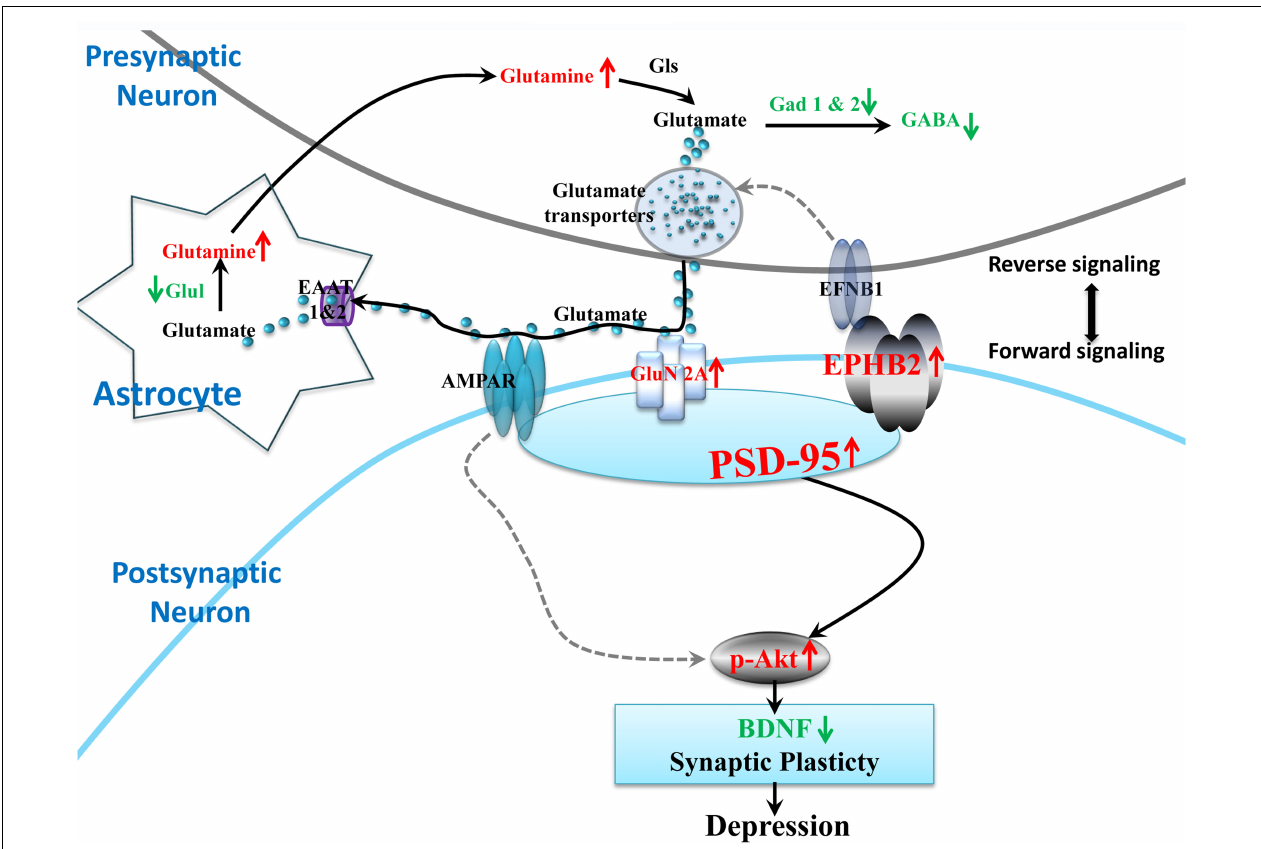
FIGURE 8 | Proposed model of the EPHB2 signaling cascade that regulates the synaptic plasticity through the phosphorylation of AKT under neuroinflammation-associated perturbation of glutamatergic transmission. LPS intervention influences the glutamatergic system, including decreased important enzymes of the glutamate metabolic pathway (Glul, Gad1, Gad2), and the elevated pivotal GluN2A receptor of glutamatergic synapse. Additionally, LPS elevates the expression of EPHB2, PSD-95 and phosphorylation of AKT (p-AKT) in the hypothalamus. EPHB2 may regulate neuroinflammation stress vulnerability by modulating synaptic plasticity via possibly facilitating GluN2A traffic, and then activating their specifically interacted protein, PSD-95. Next, the phosphorylation of AKT leads to the impairment of synaptic plasticity and ultimately depressive-like behavior. Molecular symbols with the up red arrow indicate upregulation, while those with the green arrow indicate downregulation in the LPS group compared with that in the CON. The solid black arrow lines show glutamatergic transmission interactions or synaptic plasticity regulation. The gray dotted arrow lines show regulation cited previously.